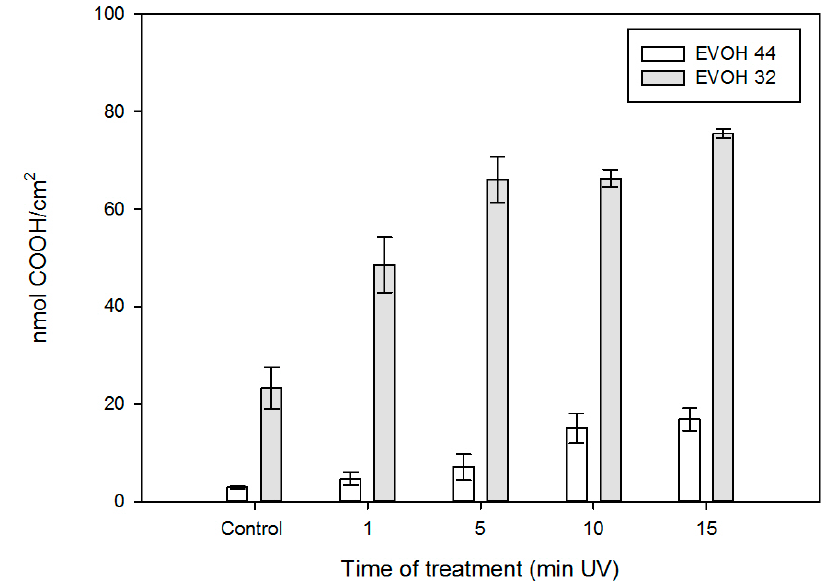
Figure 4. Surface density of COOH groups on EVOH 32 and EVOH 44 films calculated by the Toluidine Blue O (TBO) assay as a function of the ultraviolet (UV) treatment time.